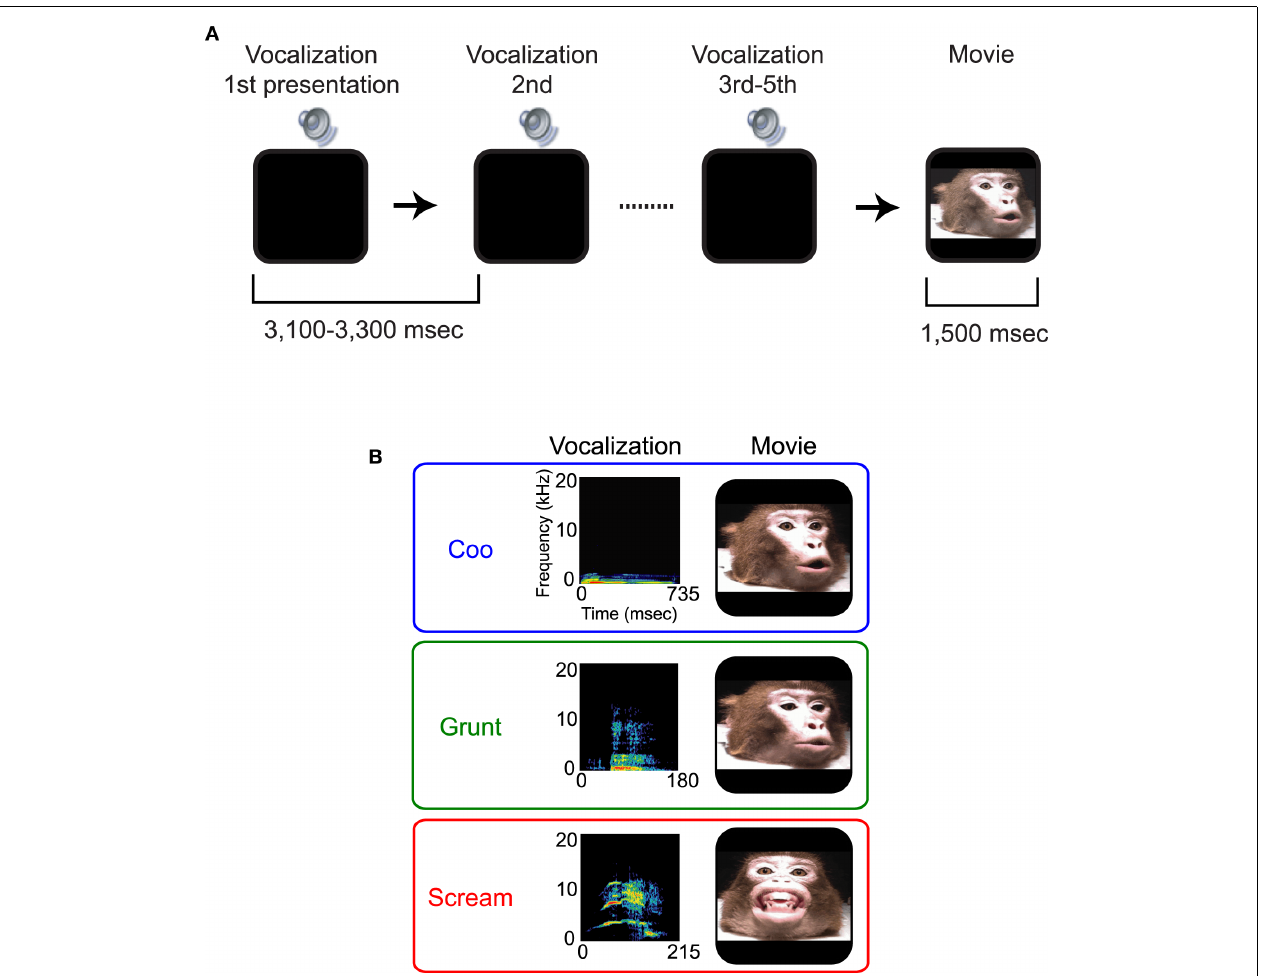
three classes of vocalizations.The top row shows the spectrogram for the coo and a frame from the movie of the monkey vocalizing the coo .The middle row shows the spectrogram of the grunt and a frame from the movie of the monkey vocalizing the grunt .The bottom row shows the spectrogram of the scream and a frame from the movie of the monkey vocalizing the scream